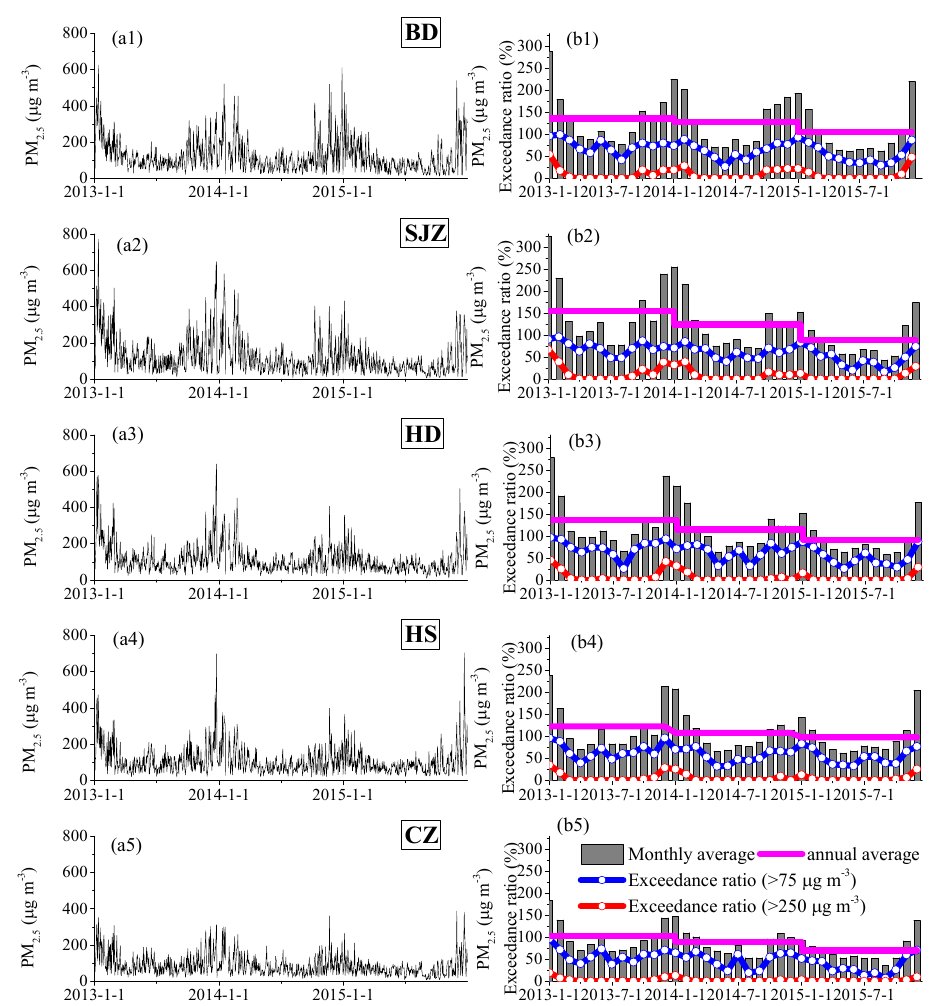
Figure 2. Daily variation ( a ) and monthly average and exceedance ratio variations ( b ) of PM 2.5 in five cities during 2013–2015. (The Grade II National Ambient Air Quality Standard for the daily limit is 75 μg m −3 ; BD-Baoding, SJZ-Shijiazhuang, HD-Handan, HS-Hengshui, CZ-Cangzhou).